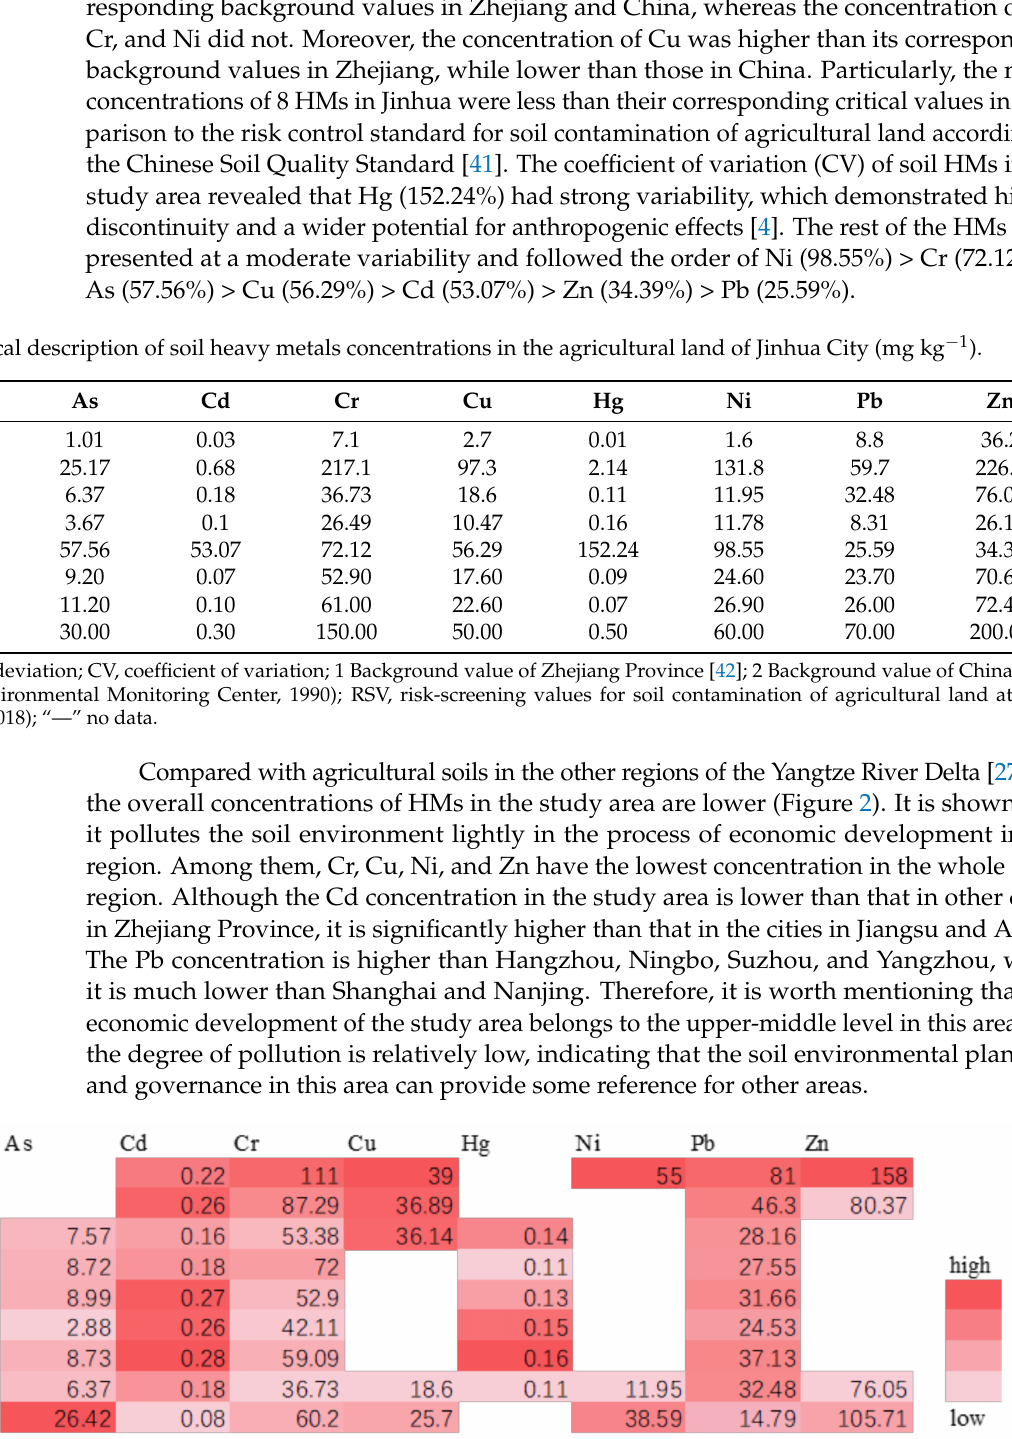
Figure 2. Contrast of soil heavy metal concentrations (mg kg − 1 ) of agricultural land in the Yangtze River Delta of